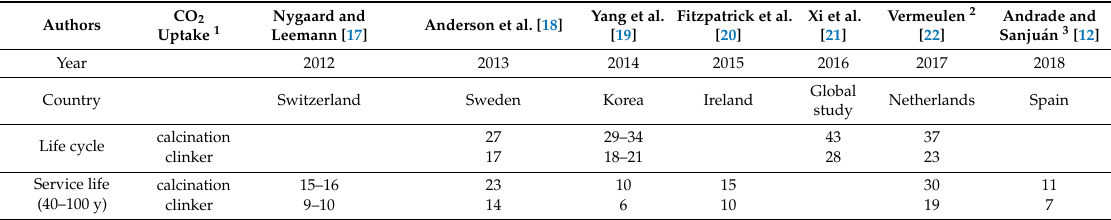
decade of the 21st century, i.e., recent studies (2011–2020),